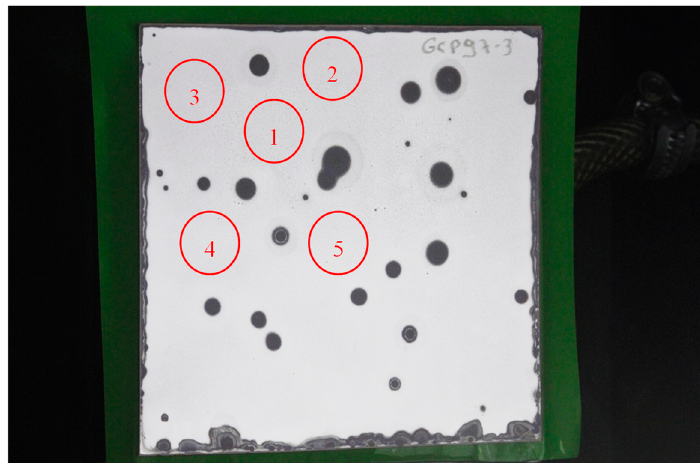
Figure 8. Five measurements taken along the non-corroded surface of a partially corroded reflector.